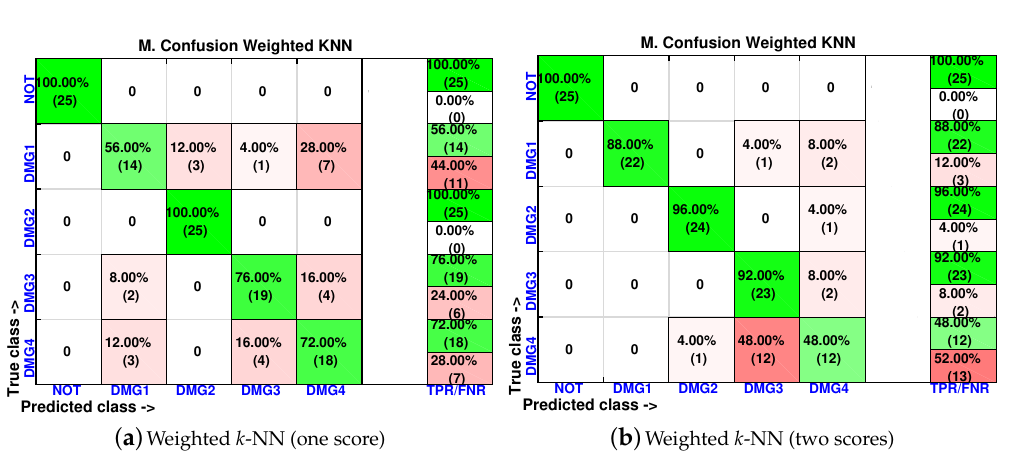
Figure 18. Confusion matrix using weighted k -NN when the feature vector is formed by the first principal component ( a ) or by the first two principal components ( b